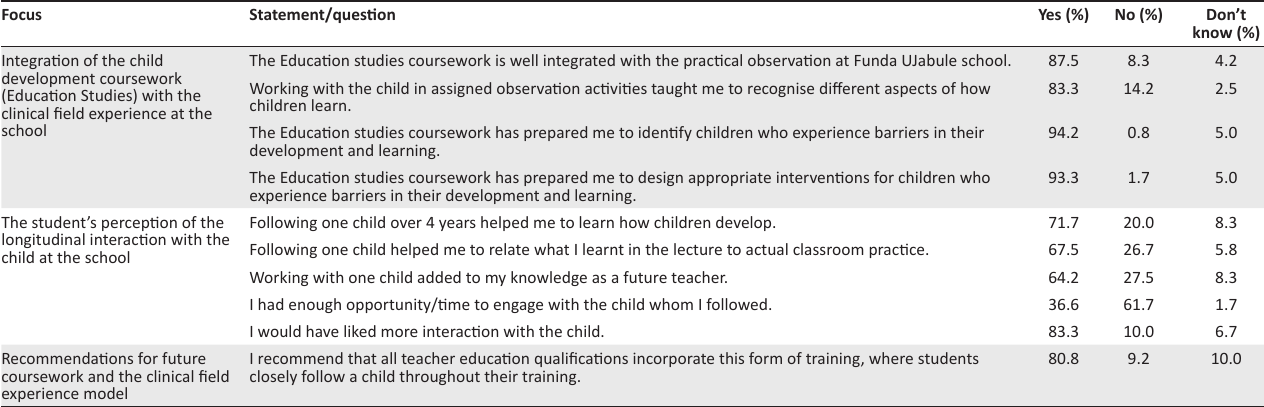
TABLE 3: Students’ response to statements in the questionnaire.